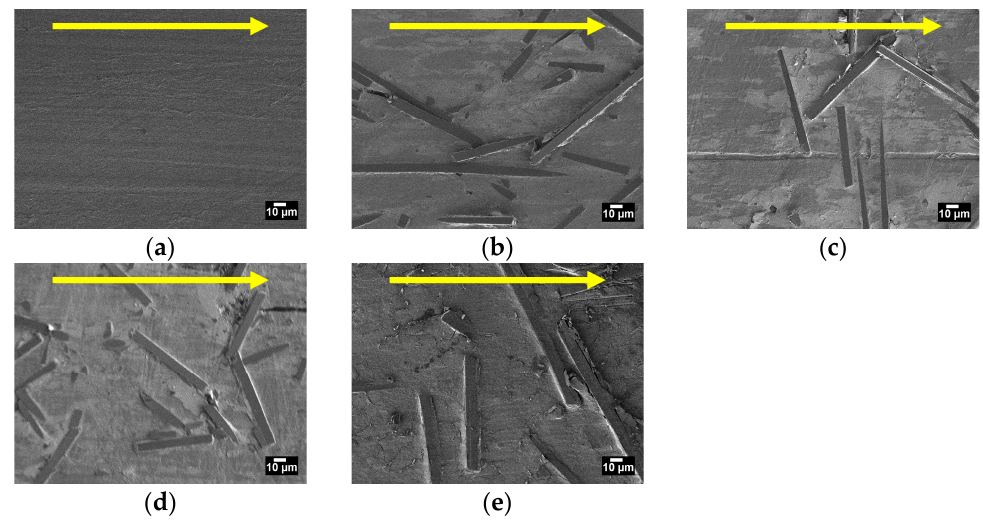
Figure 8. SEM image of worn surfaces of the initial PTFE and PCM: ( a ) initial PTFE; ( b ) PTFE/CF/SiO 2 ; ( c ) PTFE/CF/ZrO 2 ; ( d ) PTFE/CF/SiO 2 /BN; ( e ) PTFE/CF/ZrO 2